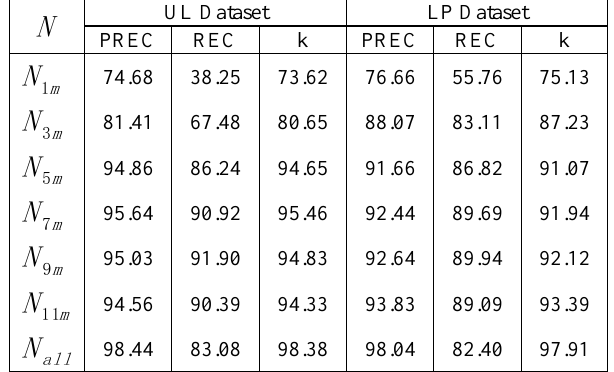
Table 2. PREC, REC and k (in %) for different neighbourhood definitions and two datasets.